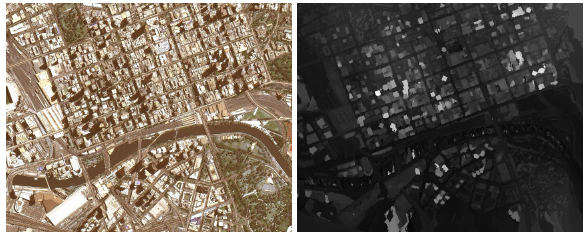
Figure 12. Spectral classification from the Pl´eiades Melbourne scene, 2500 m × 2000 m, blue: water, green: vegetation, red: shadow